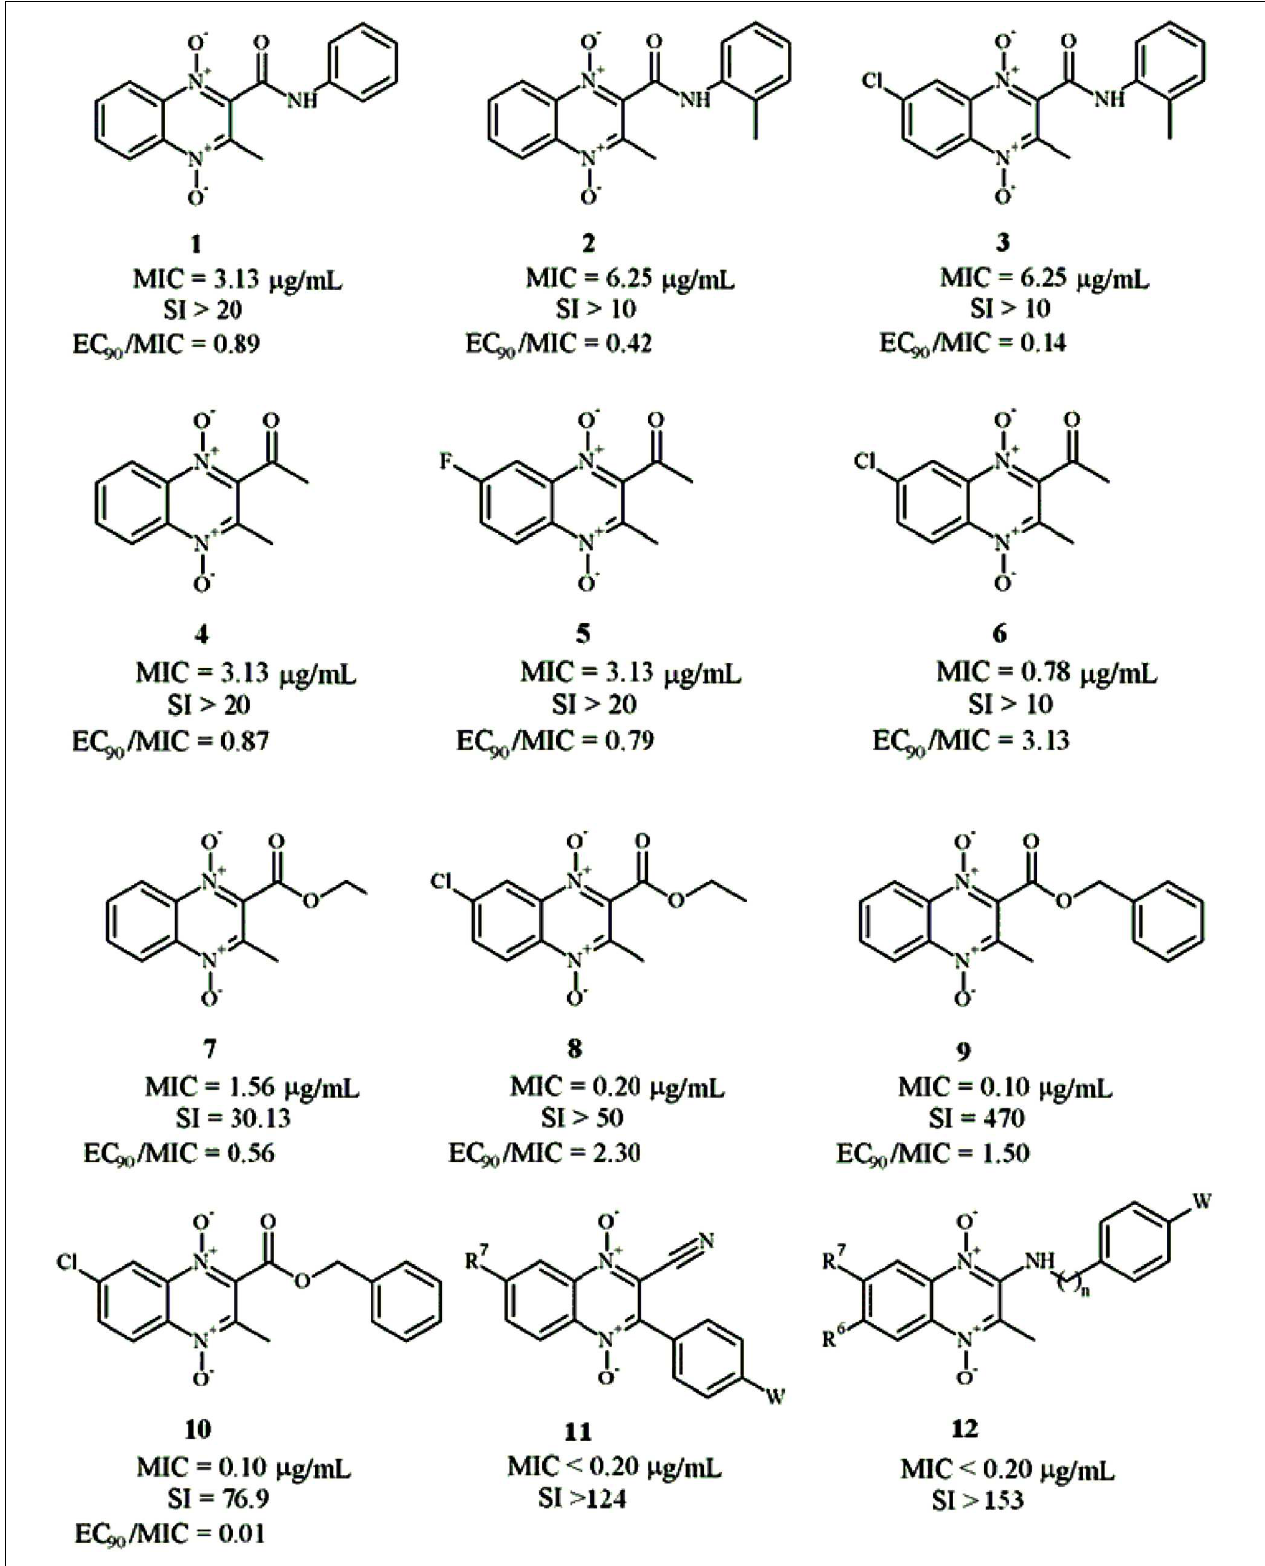
FIGURE 3 | General structures of QdNO derivatives with antimycobacterial activity published by Monge’s team [modified from Vicente et al. (2011)].